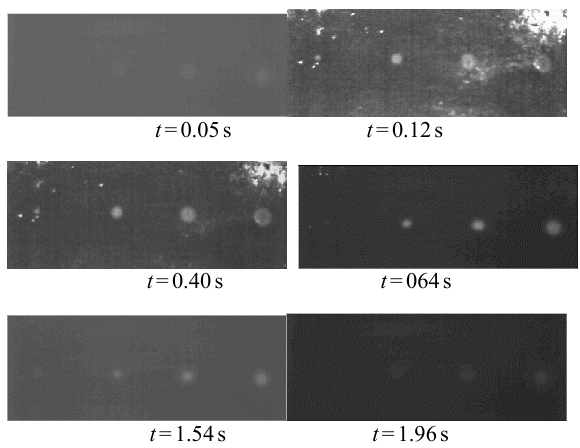
Fig. 3 Raw thermal images sequence of the specimen